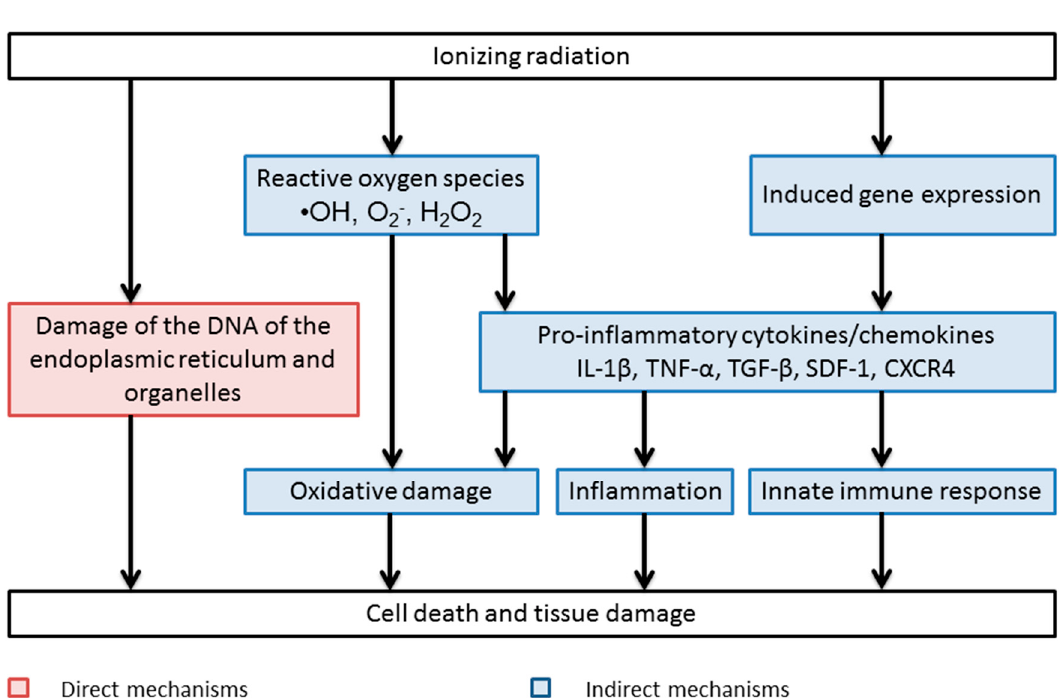
Figure 1. Direct and indirect mechanisms of cell death and damage associated with exposure to ionizing radiation.